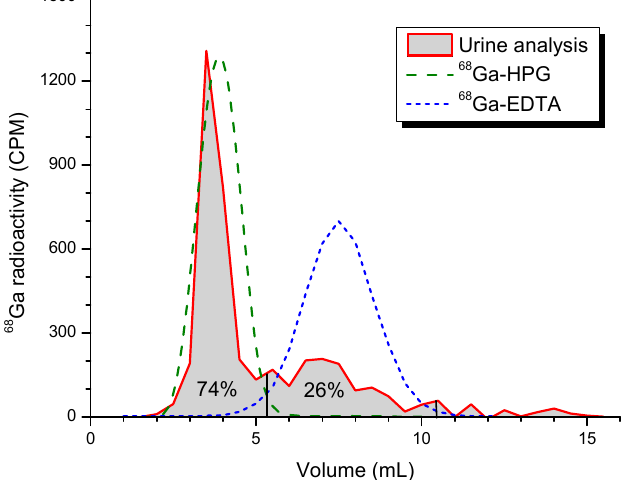
Figure 3. Size-exclusion chromatography of rat urine collected during the first hour after injection of 68 Ga-HPG into a rat. The main peak of the urine activity (74%) came at the front, where pure 68 Ga-HPG (green peak) was eluted. The other 26% of the urine activity was eluted where chelated 68 Ga elutes (the blue peak), and might thus consist of partly broken down low-molecular-weight 68 Ga-HPGs or other chelated 68 Ga species.